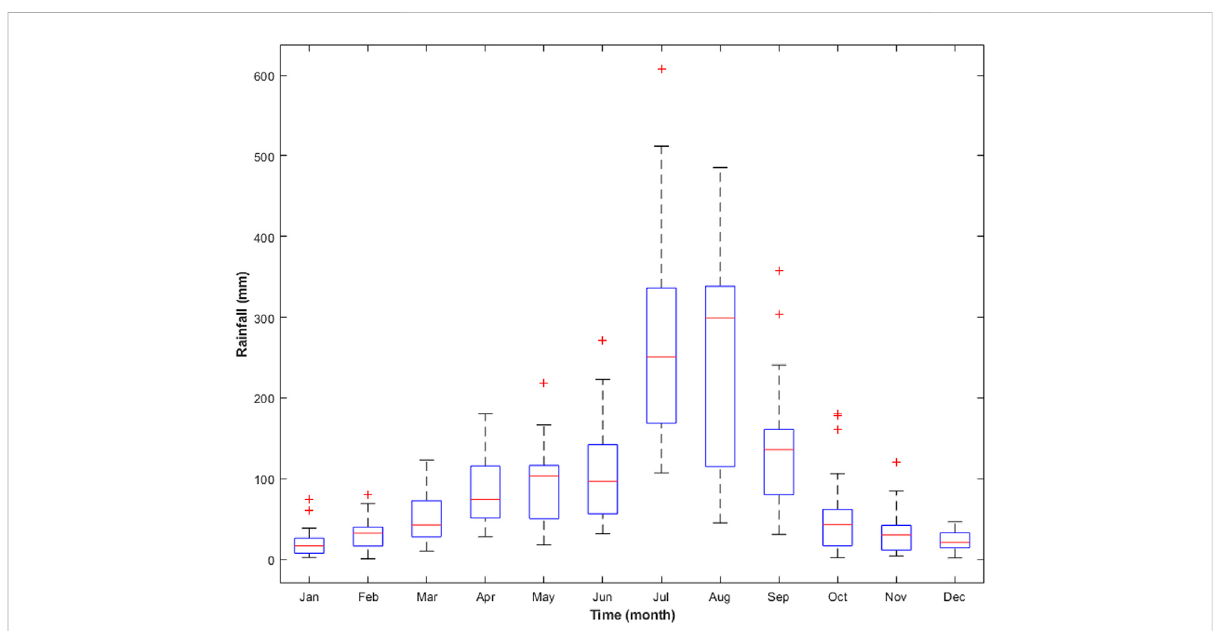
FIGURE 2 Rainfall characteristics recorded atSangju City illustratedby boxplots. The 25thand 75th percentiles are indicated by theoutside bordersof the boxes;themedianisshown asaredline inthemiddleofeachboxplot. Thewhiskersatthetopandbottomindicatethemaximumandlowest values, respectively.